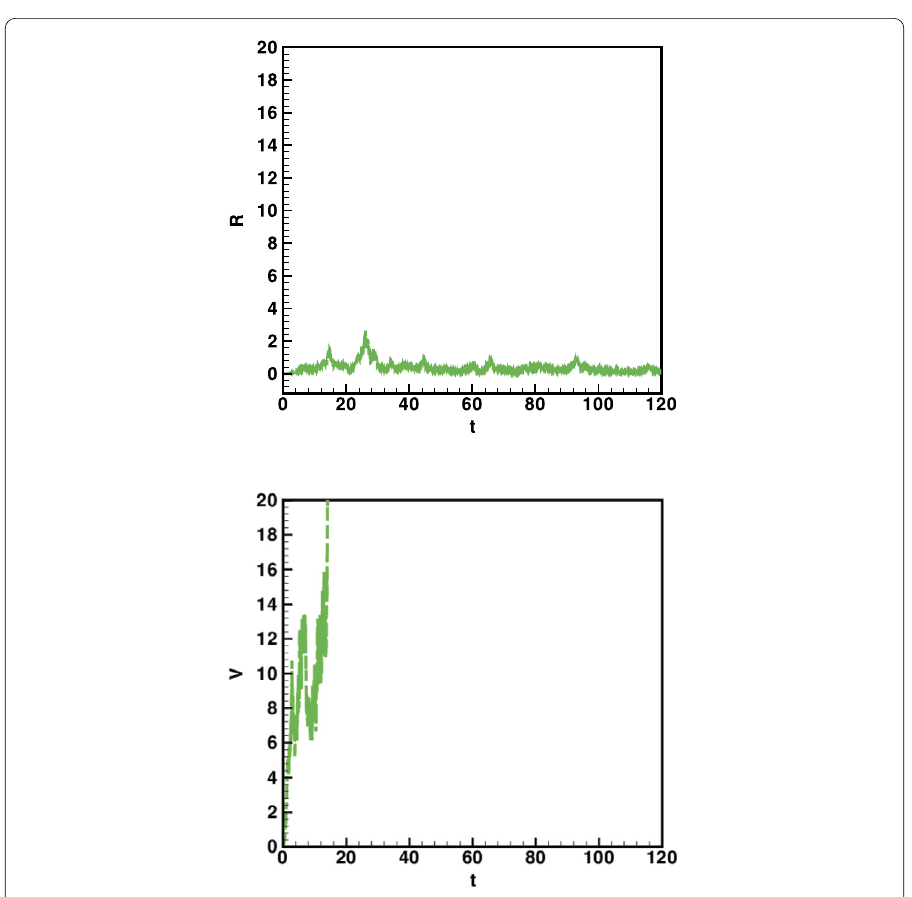
Figure 25 Stochastic behavior of R ( t ) and V ( t )